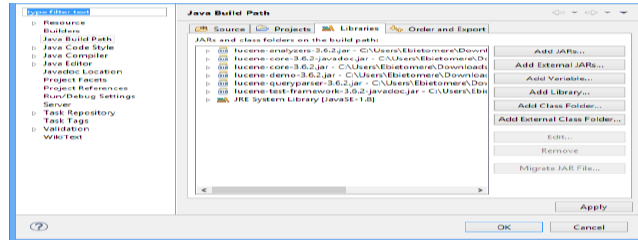
Fig. 8. Lucene configuration build path in Eclipse.